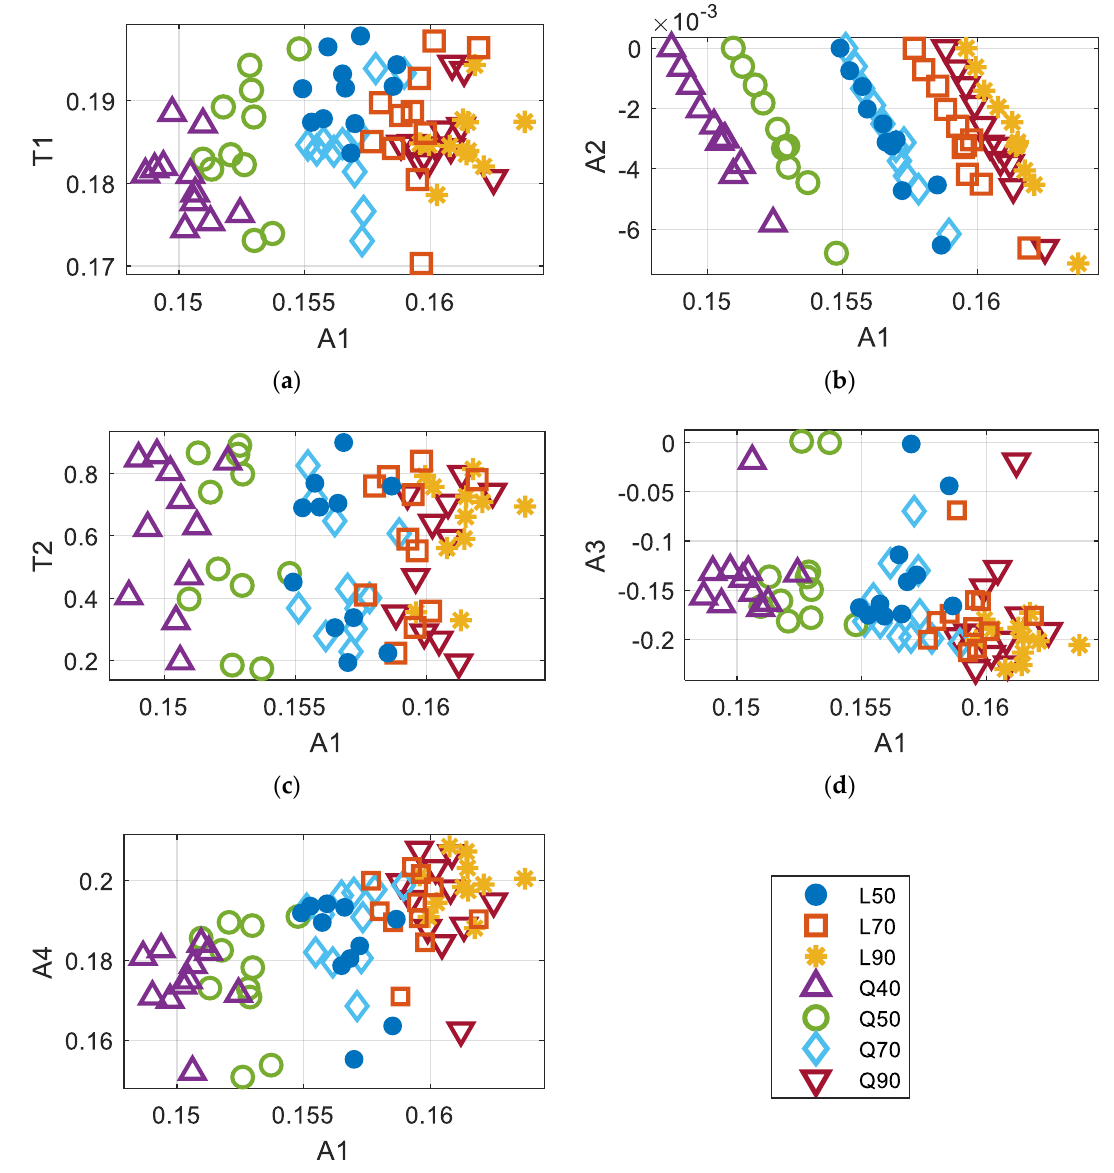
Figure 7. The distribution features over the range of A1 (Maximum Amplitude); ( a ) Relationship between A1-T1 (Maximum Time); ( b ) Relationship between A1–A2 (Maximum Tangent); ( c ) Relationship between A1-T2 (Time at Maximum Tangent); ( d ) Relationship between A1–A3 (Linear regression slope); and ( e ) Relationship between A1-A4 (Linear regression y-intercept).